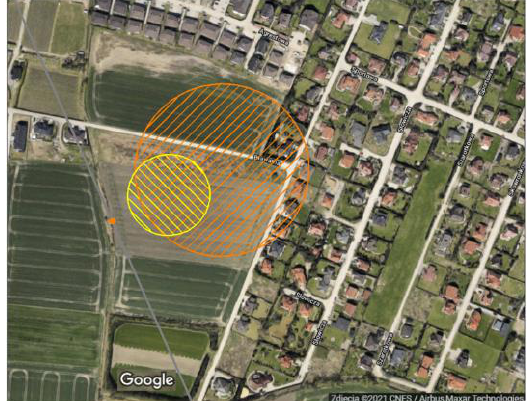
Figure 20. Hazard zones due to a jet fire for a natural gas pipeline (a = 0.2): yellow zone, p = 1 MPa; orange zone, p = 5 MPa.